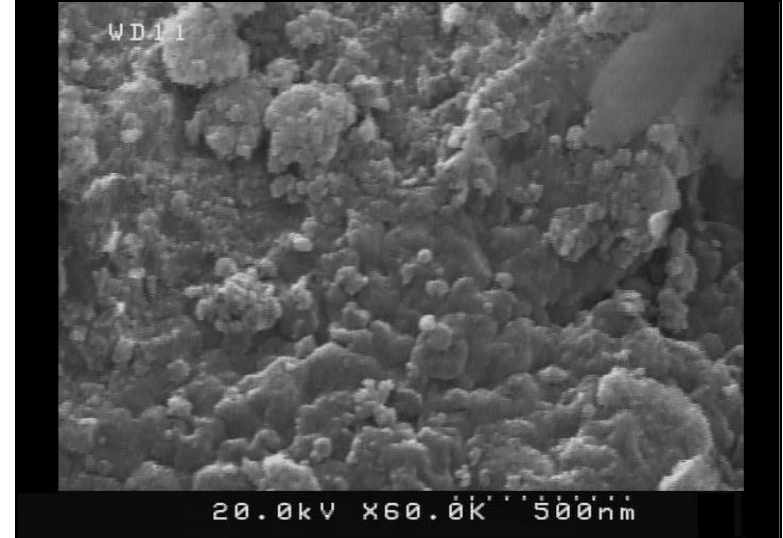
Figure 4: SEM image of Cr2O3 sample obtained at precursor concentration of 0.1 5M by